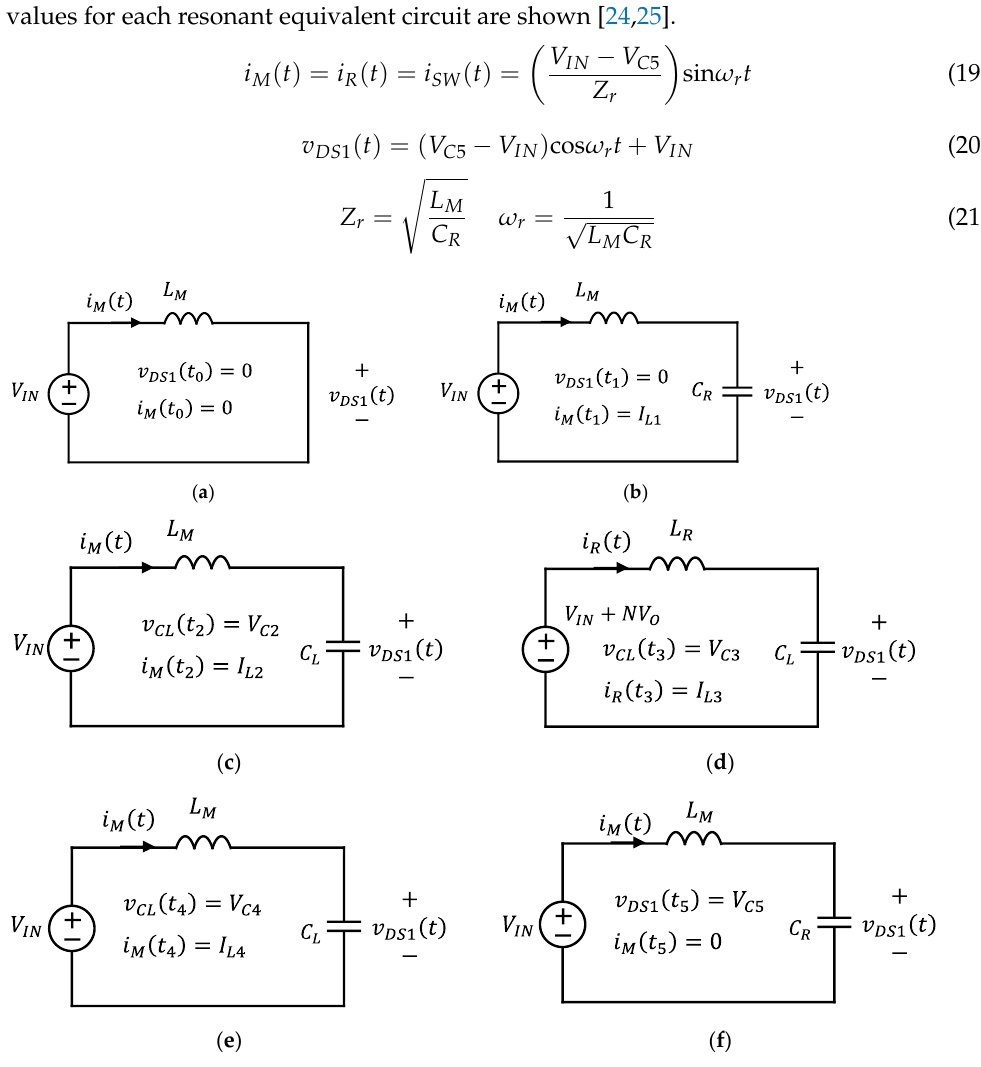
Figure 11. Equivalent circuit in state 6.